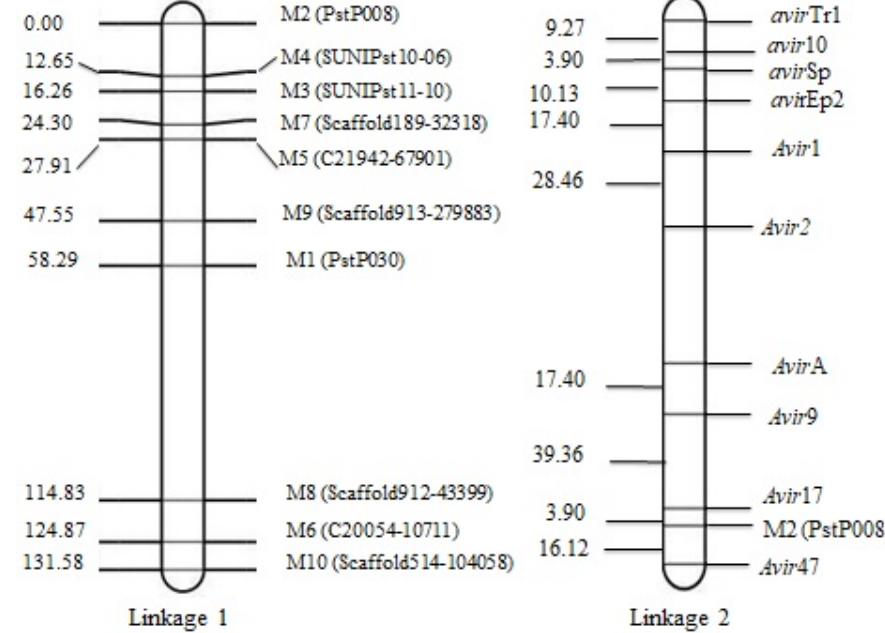
Figure 2. Genetic maps constructed with QTL Ici Mapping; linkage 1 consists of 9 SSR markers and linkage 2 consists of 1 SSR marker and 10 avirulence/virulence genotypes.